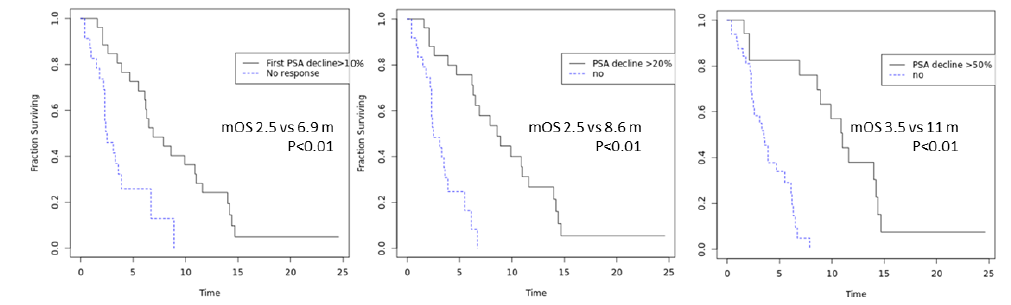
Figure 2. Overall survival in patients according to extent of PSA decline.